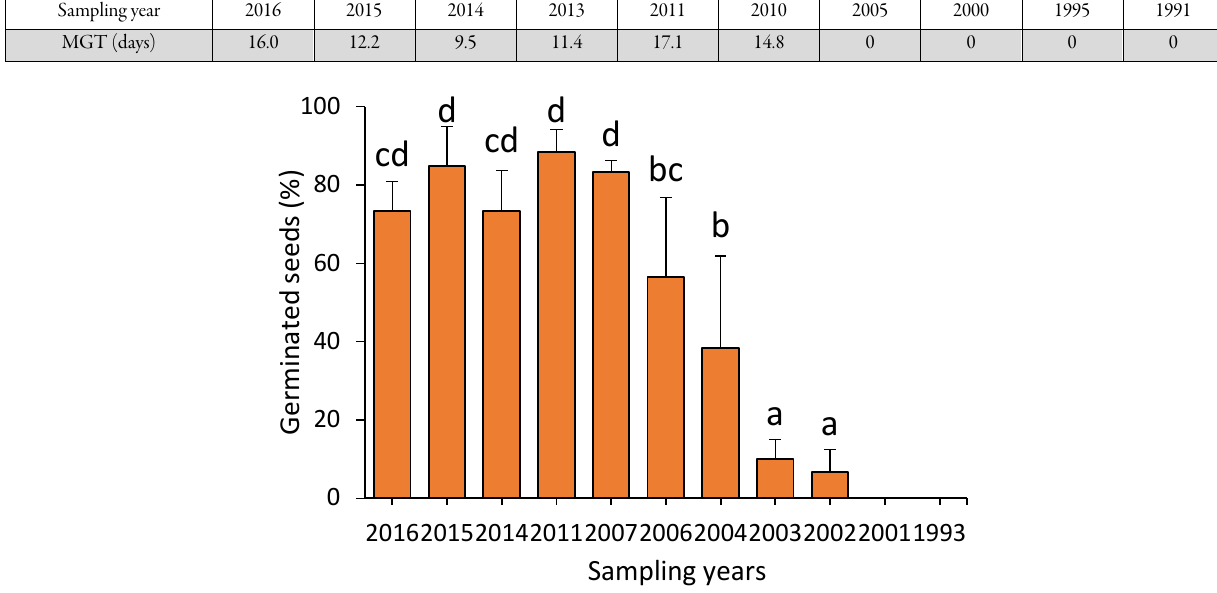
Table 2. Effect of seed storage time on germination velocity, expressed as ‘mean germination time’ (MGT), in Centaurea dracunculifolia Sampling year